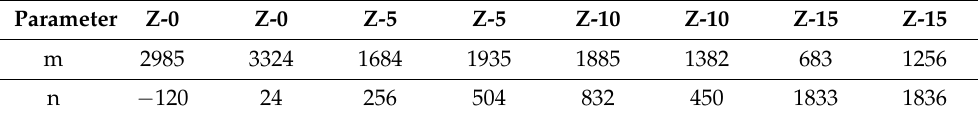
Table 3. AE accumulative parameters.